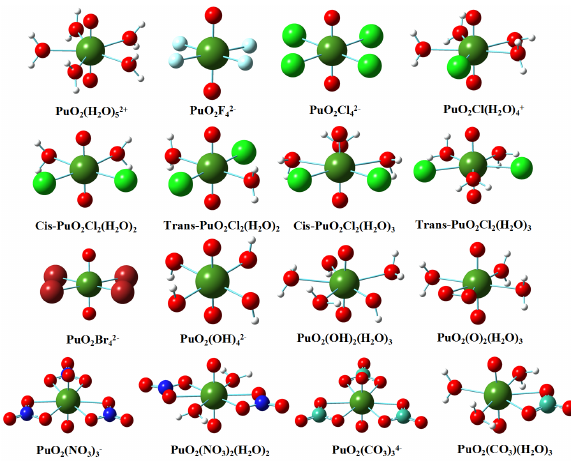
Figure 1. The relaxed geometry structures of Plutonyl (VI) complexes in gas phase optimized at B3LYP/SARC-ZORA level of theory. Table 2. The calculated bonding lengths (Å) of a series of Plutonyl (VI) complexes in gaseous and aqueous phases calculated at B3LYP/SARC-ZORA level of theory, the structural parameters obtained with B3LYP/SDD are given in the